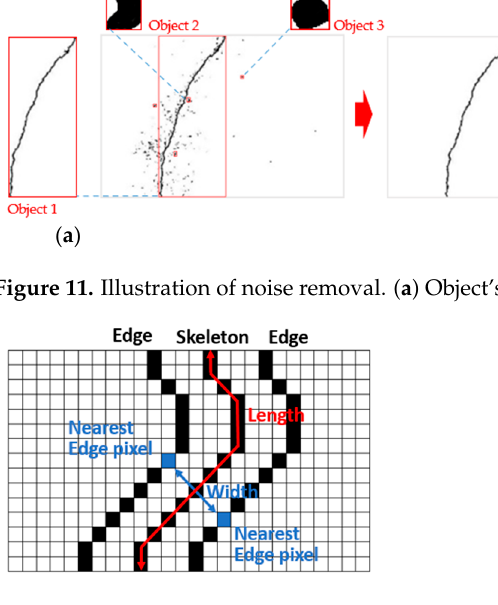
Figure 12. Illustration of crack width and length calculations [23].